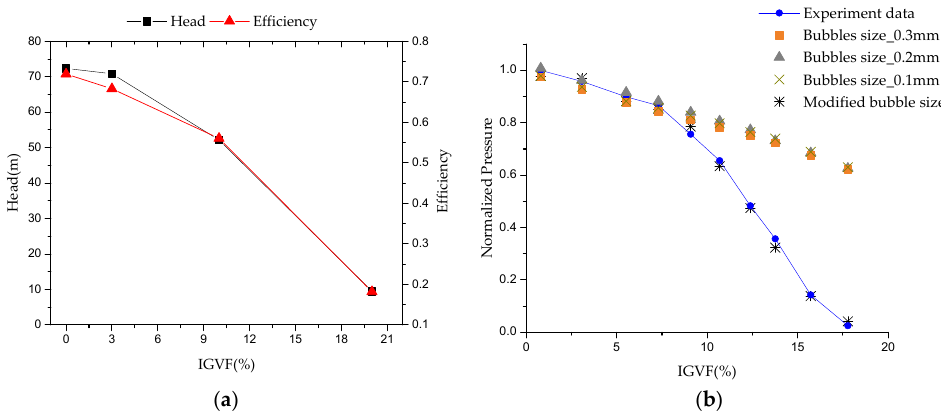
Figure 6. Hydraulic performance curves under different inlet gas volume fractions (IGVFs). ( a ) pump in this study; ( b ) Zhu [37].